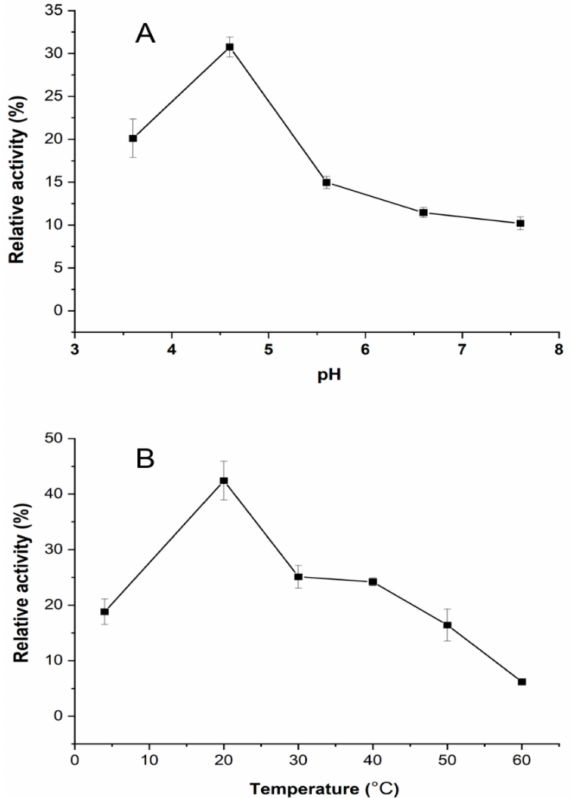
Figure 5. Effect of pH and temperature on the activity of tocopherol oxidase from fresh corn germs (( A ), activity of tocopherol oxidase as a function of pH at room temperature; ( B ), activity of tocopherol oxidase as a function of temperature with optimal